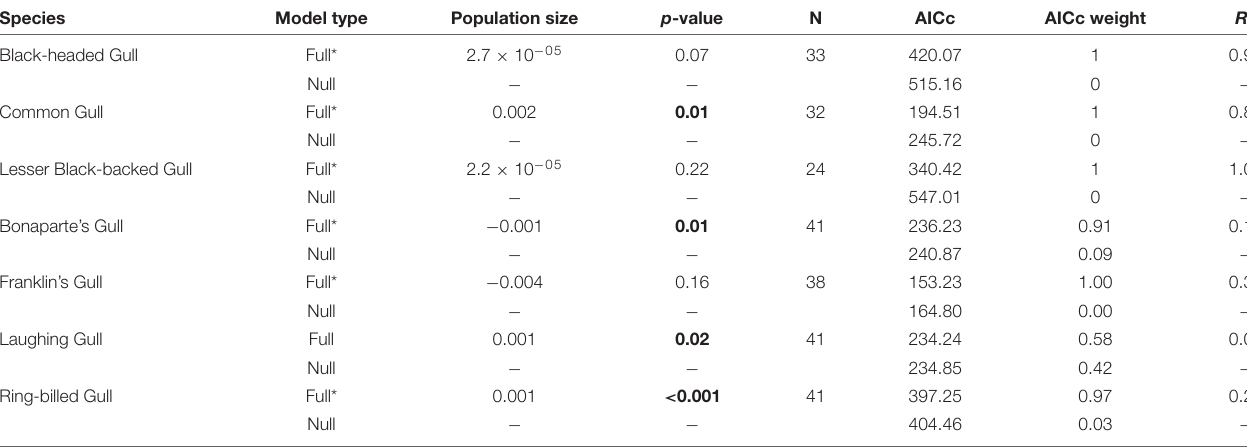
Models were parameterized with negative binomial distribution of errors and log link function. Effect sizes are listed for the predictor. *Best model as selected based on the lowest AICc value. Significant p-values of the explanatory variable are shown in bold (i.e., p <